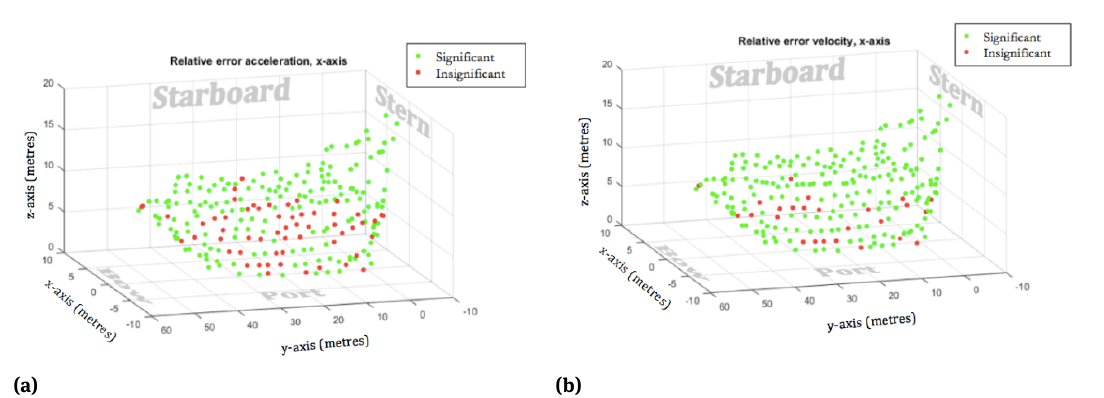
Figure 4: Significant and insignificant a) accelerations and b) velocities along the x -axis.